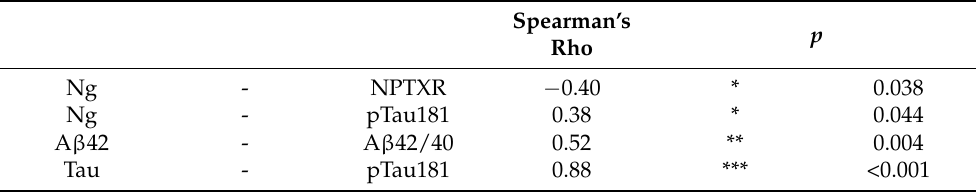
Table 3. Spearman’s correlations between CSF tested proteins and neurochemical biomarkers in the AD patients. Legend—Level of statistically significant *** p < 0.001, ** p < 0.01, * p < 0.05, Ng—neurogranin, NPTXR—neuronal pentraxin receptor, A β 42—amyloid Beta 1-42, A β 42/40—amyloid Beta 1-42 to 1-40 ratio.